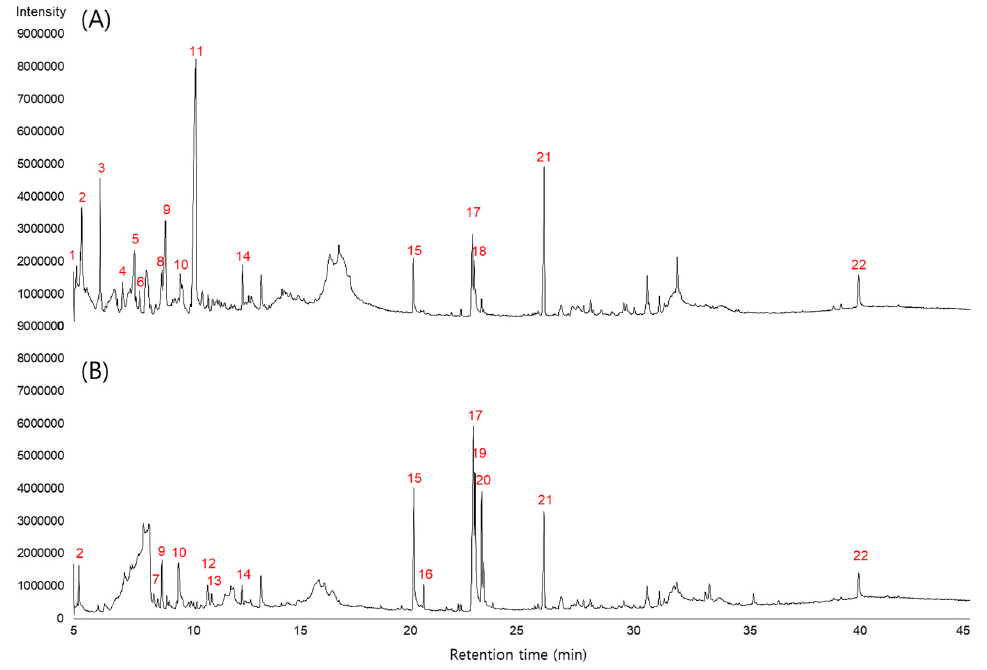
Figure 2. Gas chromatography and mass spectrometry (GC-MS) chromatogram of ( A ) SME and ( B ) SMBE.